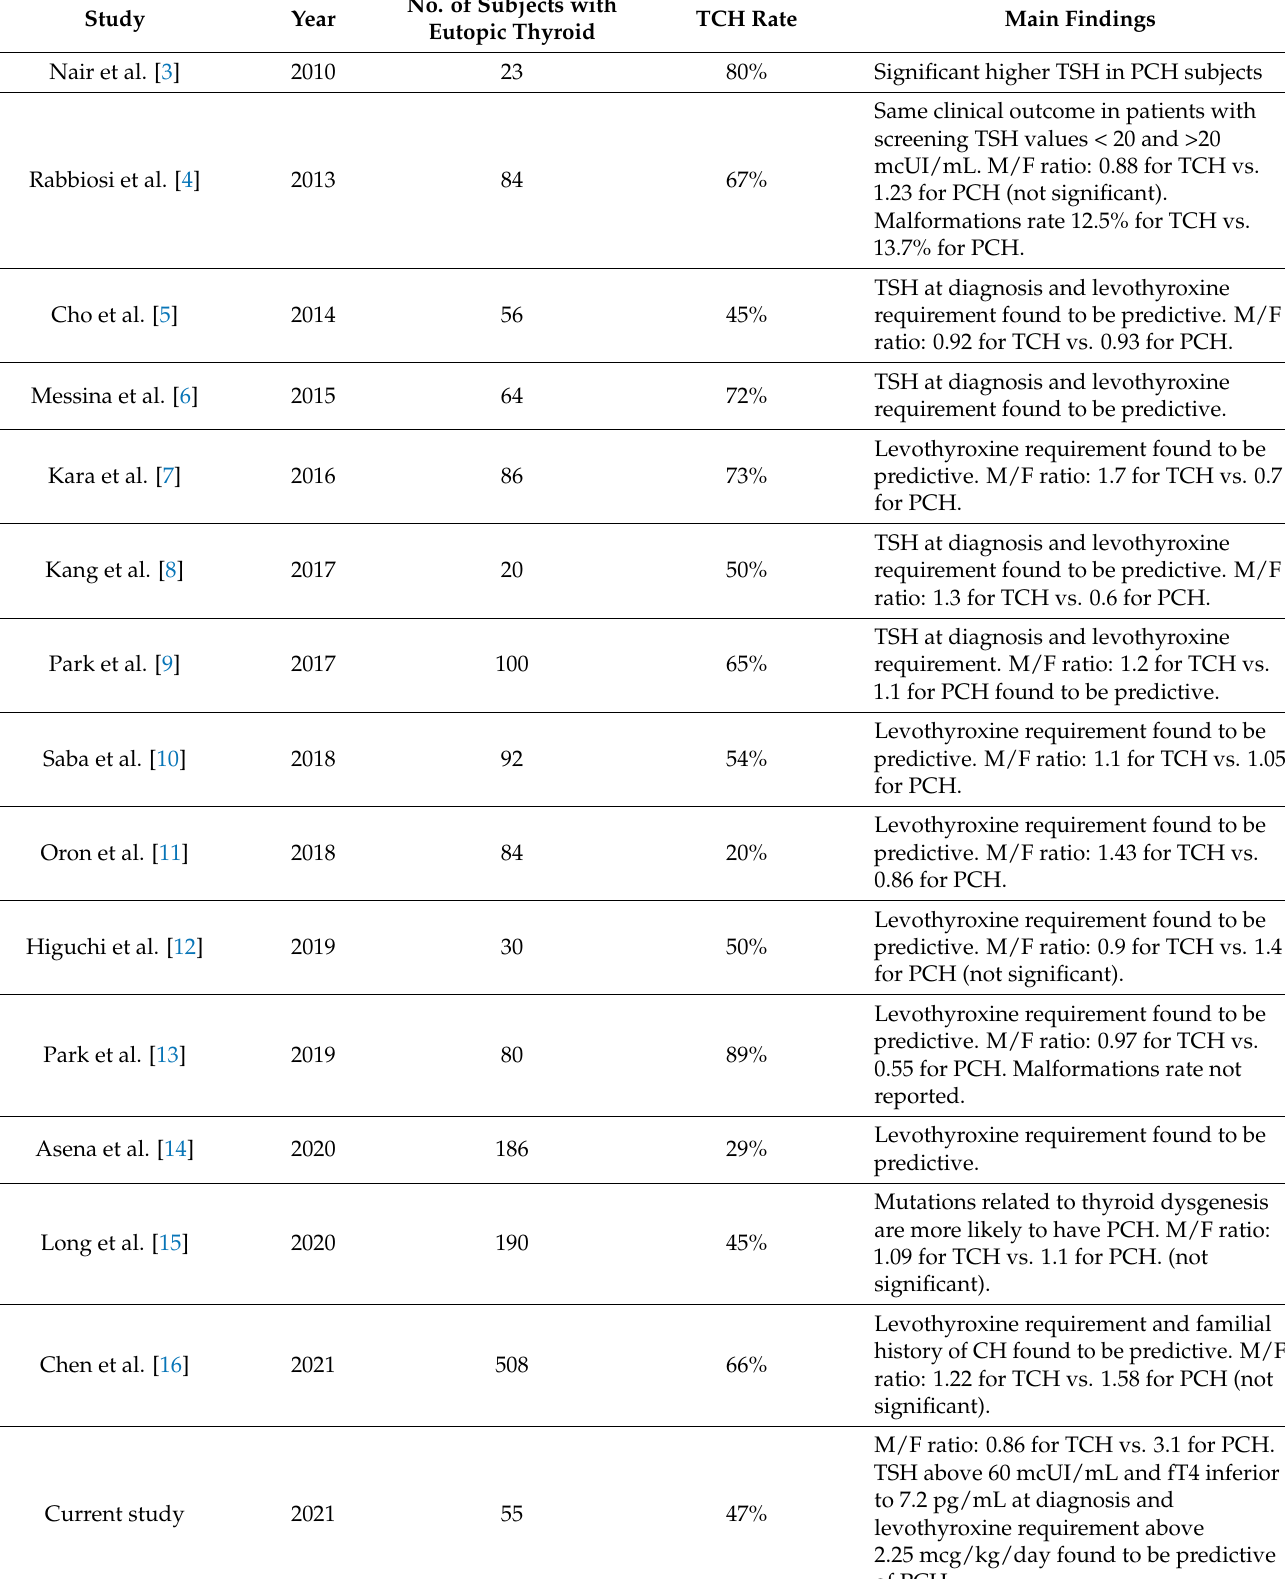
Table 2. Main studies on TCH and PCH in infants with CH and eutopic thyroid